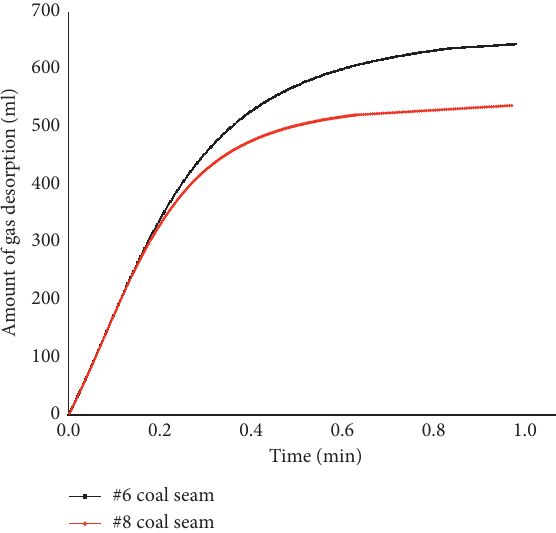
Figure 9: Variation law in the gas desorption speed. Figure 10: Variation law in the gas